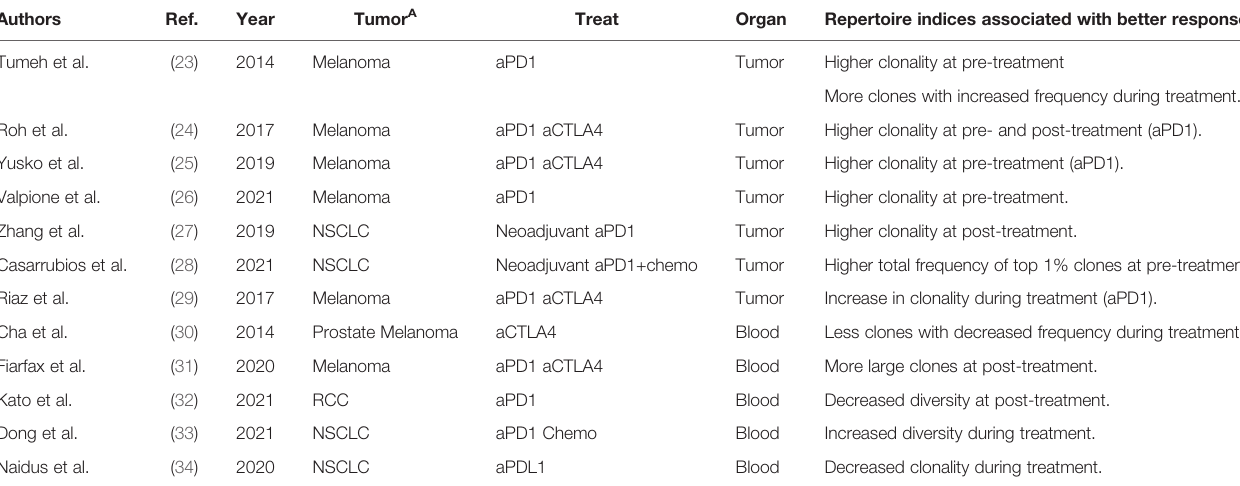
TABLE 3 | Previous studies analyzing the association between repertoire clonality/diversity and clinical responses.